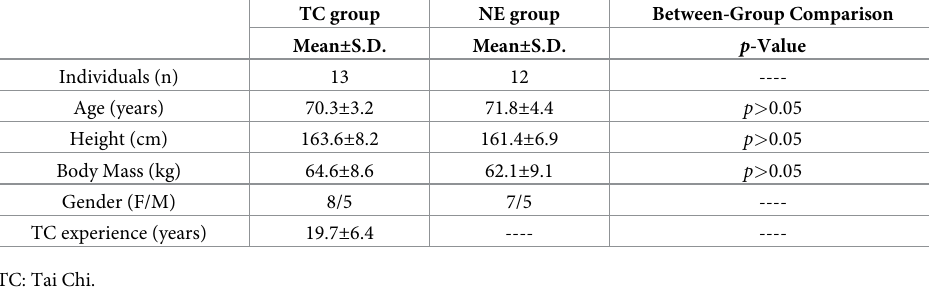
Table 1. Demographic characteristics of practitioners in TC and control